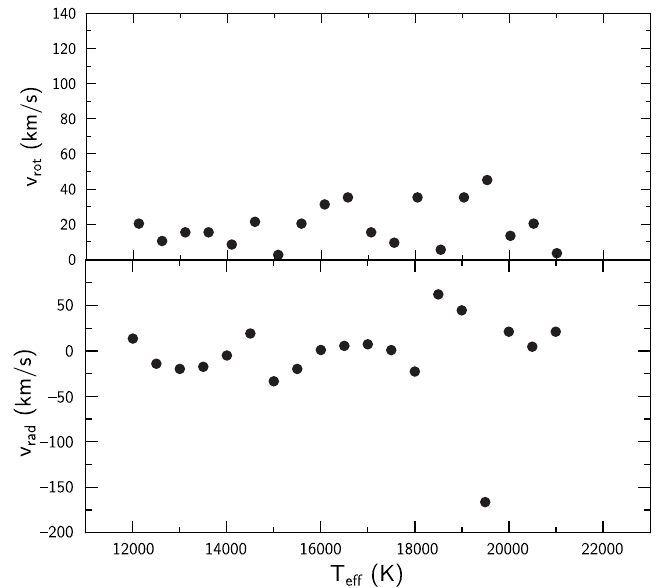
Fig. 2. Rotational (top) and radial (bottom) velocities of all components of the Mg II resonance lines vs. T eff .